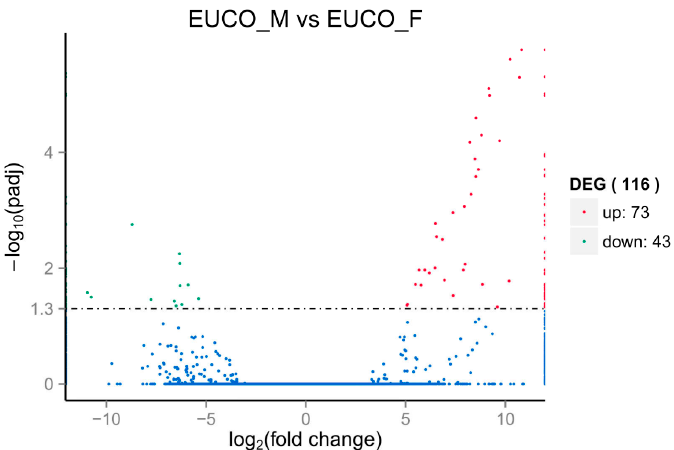
Figure 2. Volcano plot of the identification of DEGs (differentially expressed genes) between the males and the females of Eucommia ulmoides . X axis represents the log 2 (fold change value), while Y axis represents –log 10 ( p adj value). Green dots show the female-biased genes, and red dots represent the male-biased genes. EUCO_M: Males; EUCO_F: Females.